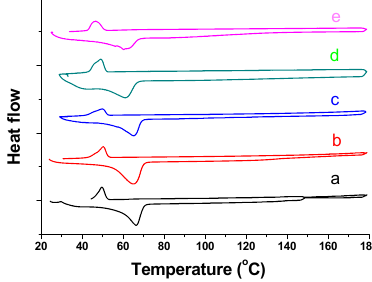
Figure 5. Differential scanning calorimetry (DSC) curve of pure sol–gel fiber (a) and hybrid fibers in which volume ratios of CL sol–gel solution and PGS solution were 95/5 (b); 90/10 (c); 85/15 (d) and 80/20 (e). The stress–strain curves, and corresponding tensile modulus, tensile strength, and elongation at failure values of the electrospun hybrid fibers are given in Figure 6. For pure CL sol–gel fibers, Young’s modulus, tensile strength, and elongation at failure values were found to be 14.8 ± 0.9 MPa, 1.2 ± 0.1 MPa, and 40 ± 2%, respectively. By incorporating PGS, mechanical properties of the sol–gel fibers can be greatly improved, especially tensile strength and stretchability. When PGS was added to the sol–gel mixture, tensile strength, and elongation at failure gradually improved with increasing